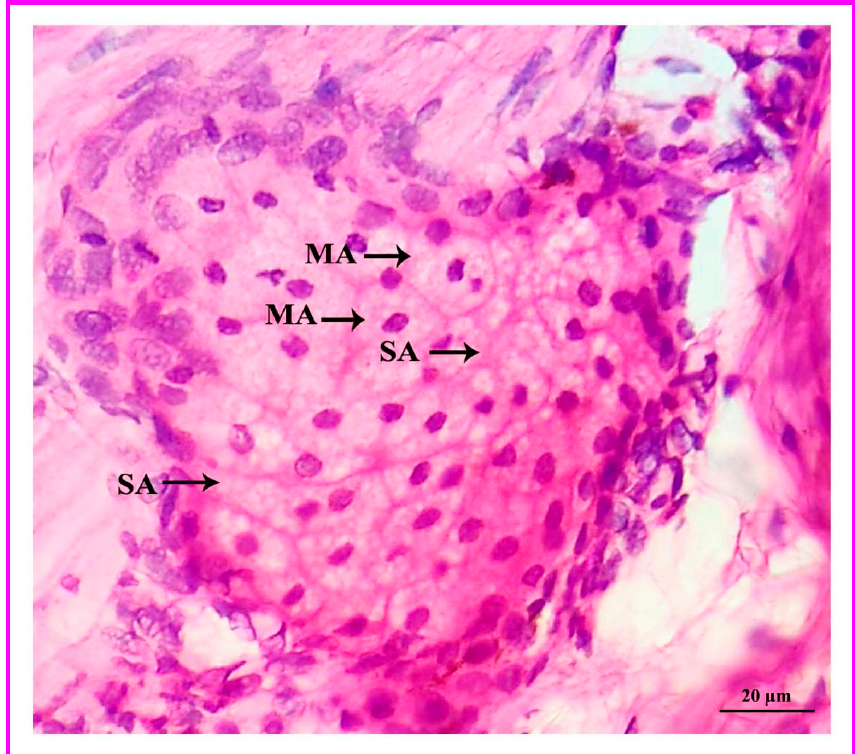
Figure 11. Simple alveolar holocrine sebaceous glandular lobules and the cytoplasm become hon- eycombed in appearance. MA: mucus acini; SA: serous acini. 3.4. Density and Diameter of Apocrine and Sebaceous Lobules Microscopic examination revealed that male and female Vembur sheep’s interdigital glands differ in the density and diameter of apocrine and sebaceous secretory glands. As revealed in the paired sample t -test, the apocrine and sebaceous gland densities are sig- nificantly (AG: t = 2.61, df = 5; SG: t = 3.33, df = 5; p < 0.05) higher in male glands (AG: 47.5 ± 2.83 units/mm 2 ; SG: 28.83 ± 1.42 units/mm 2 ) than in female glands (AG: 34.86 ± 2.81 units/mm 2 ; SG: 21.66 ± 1.41 units/mm 2 ). Further, the diameter of apocrine and sebaceous secretory lobules varied significantly (AG: t = 4.75, df = 5; SG: t = 5.82, df = 5, p < 0.05) in the male gland (AG: 6.22 ± 0.31 μ m; SG: 8.01 ± 0.40 μ m) compared to female gland (AG: 4.65 ± 0.26 μ m; SG: 5.81 ± 0.20 μ m). 3.5. SEM Analysis of Interdigital Gland Scanning electron microscopy (SEM) was adopted to evaluate the interdigital glands (Figure 12). The gland shows two glandular components: one displaying apocrine secre- tory lobules and the other with sebaceous secretory units (Figure 12A). The apocrine se- cretory lobules are quite tall and often exhibit apocrine blebs, designating the pinching off of secretion to the lumen (Figure 12B). The sebaceous secretory lobules are positioned clustering the inner surface and appear like a group of bubbles (honeycomb) and clusters of secretory acinar cells (Figure 12C). The apocrine lobules usually appear as a group of tortuous tubules, and their lumen is often occupied by secreted content and the secretory vesicles (Figure 12D).